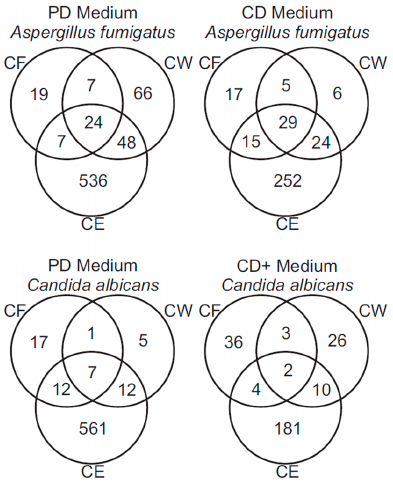
Figure 2. Number of proteins quantified in A. fumigatus and C. albicans fungal fractions. PD—Potato Dextrose Medium; CD—Czapek Dox Medium (+—with casamino acid supplementation); CE—Cell Extract Fraction; CF—Culture Filtrate Fraction; CW—Cell Wall Fraction. Protein numbers in overlapping sections of the Venn diagrams are of those shared by multiple fractions. Table 1. Number of proteins quantified in each fungal fraction *. Species Growth